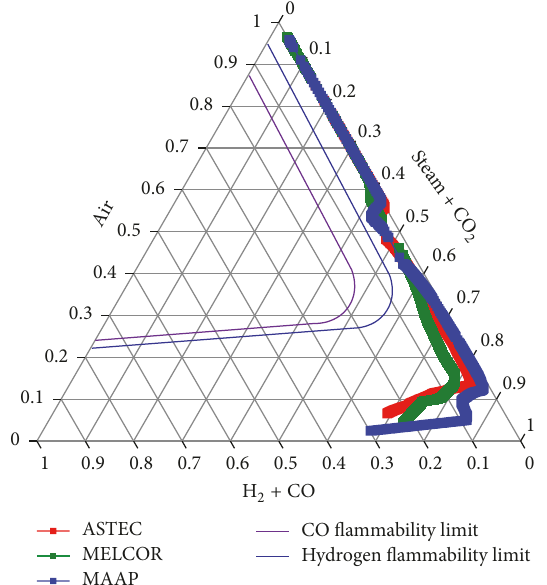
Figure 21: Flammability limits of the air – H 2 + CO – steam + CO 2